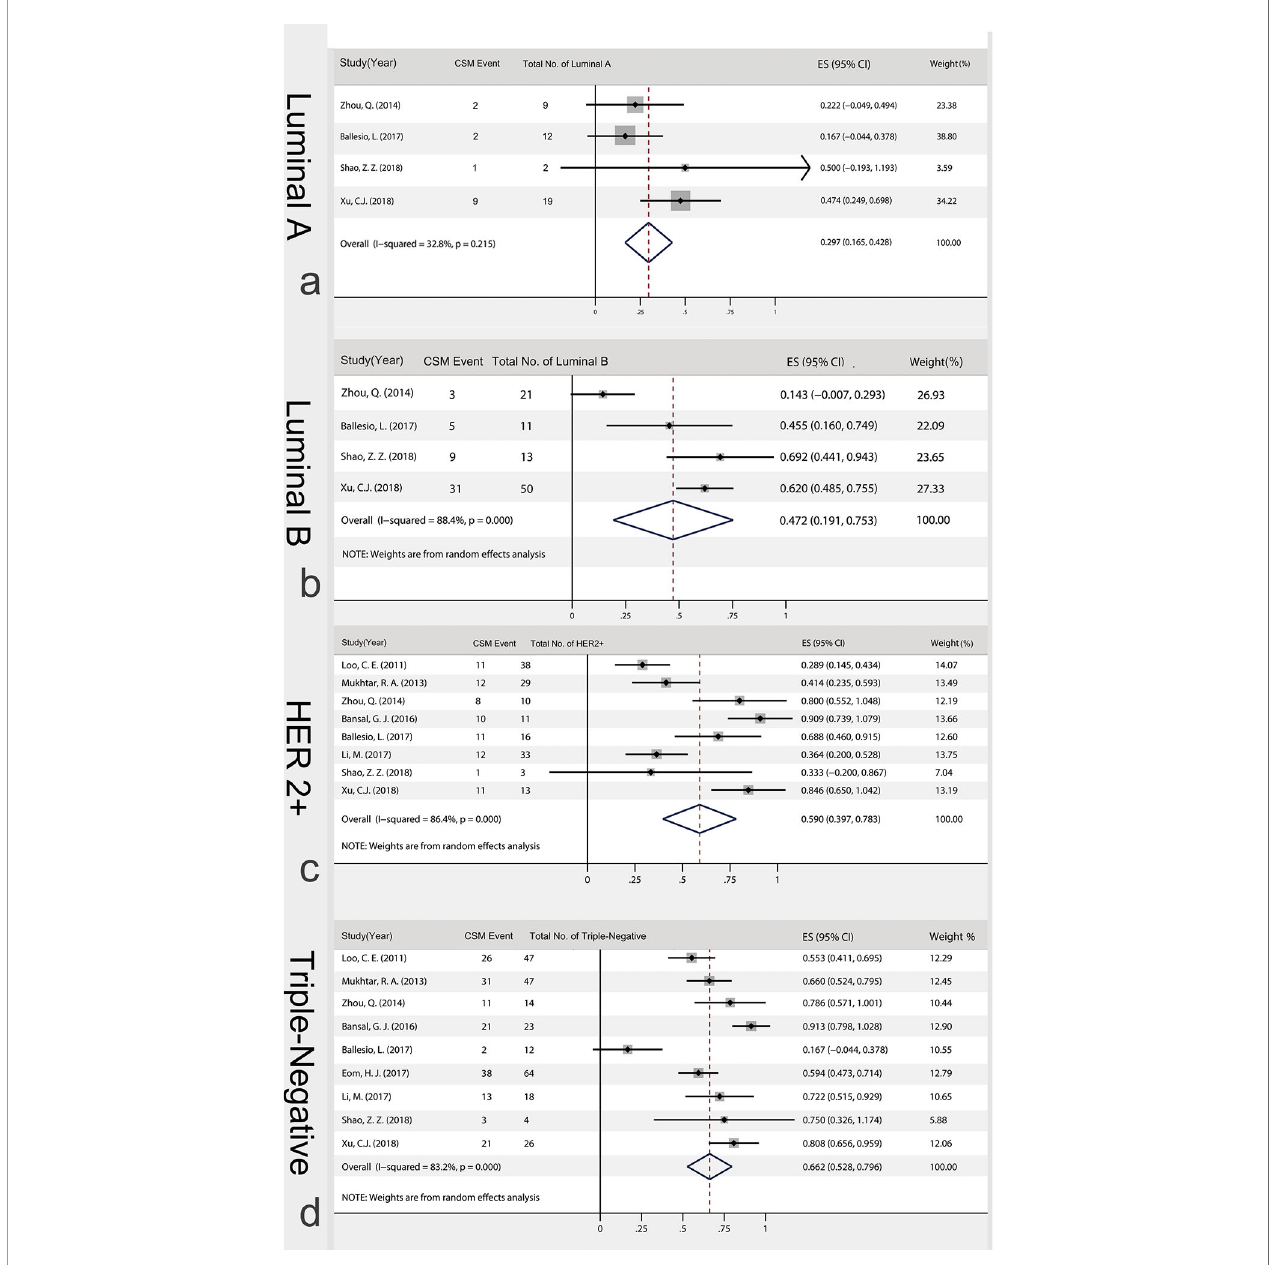
FIGURE 6 | Calculation of the subtypes-speci fi c CSM%. (A) 14 of 42 luminal tumors showed CSM (Luminal A); (B) 48 of 95 luminal B tumors showed CSM. (Luminal B); (C) 76 of 153 HER-2 positive tumors showed CSM (HER2+); (D) 166 of 255 triple-negative tumors showed CSM. (triple-negative); CSM, concentric shrinkage mode; ES, effect